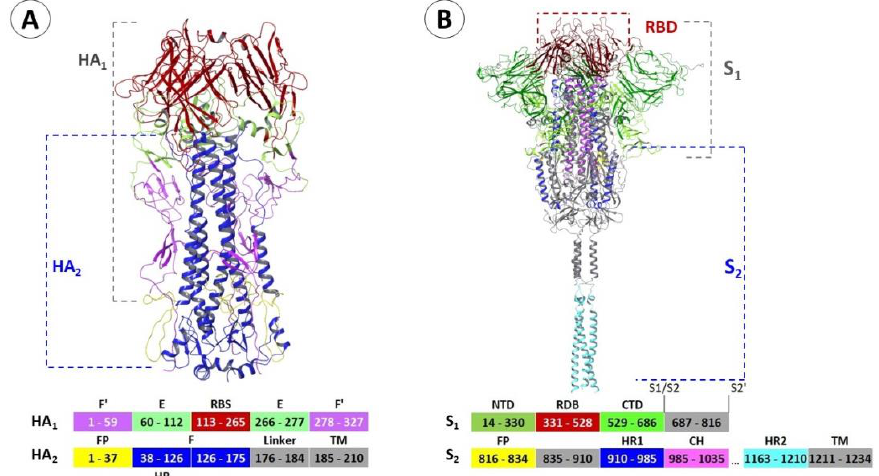
Figure 1. Structural features of the surface proteins of influenza virus and coronavirus according to X-ray diffraction analysis from Protein Data Bank [13]. Hemagglutinin ( A ) (amino acids numbering corresponds to PDB codes: 6Y5L and 1RU7 [10,14]): F’ (a. a. 1–59) and F’ (a. a. 278–327) are N- and C- terminal subdomains of HA 1 ; E-domain [14] contains RBS—receptor-binding site, FP—fusion peptide, HR—heptad repeat, and F (a. a. 38–175) is a subdomain of HA 2 ; TM—trans-membrane domain. S-protein ( B ): NTD—N-terminal domain; RBD—receptor-binding domain; CTD—C-terminal domain; S 1 /S 2 , S 2 (cid:48) —sites of proteolysis; FP—fusion peptide; HR—heptad repeat, CH—central heptad; TM— trans-membrane